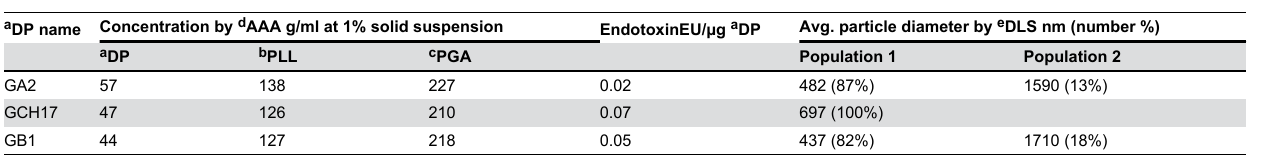
Table 2. Quality control data for nanoparticle